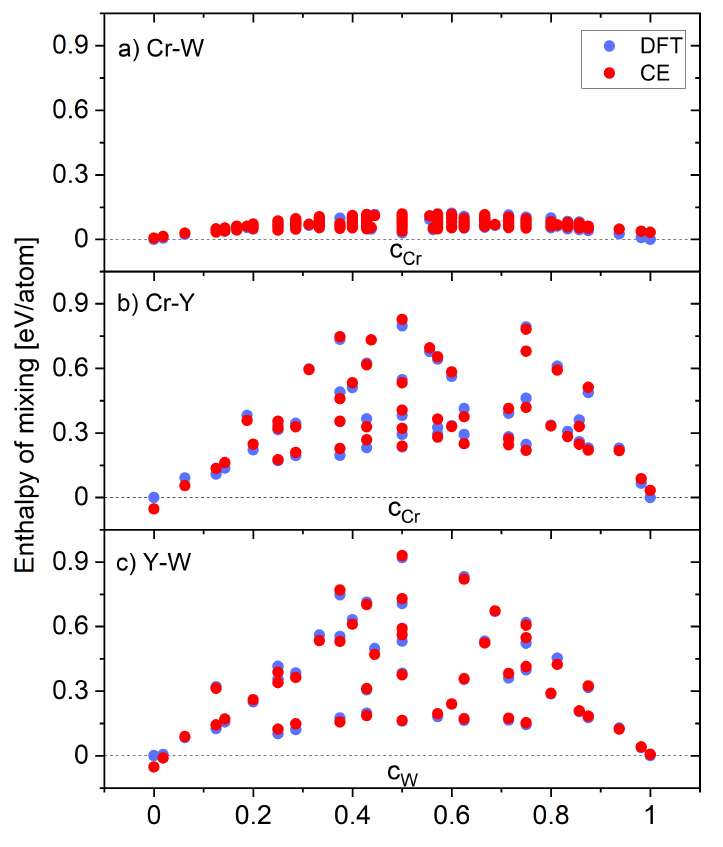
Figure 4. Enthalpies of mixing of bcc binary structures for ( a ) Cr-W, ( b ) Cr-Y, and ( c ) Y-W systems from DFT (blue) and CE (red) simulations.